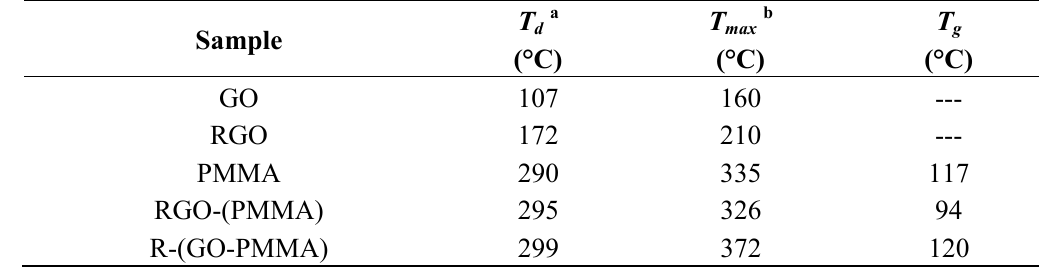
Table 2. Summary of the thermal behavior data obtained from TGA and DSC